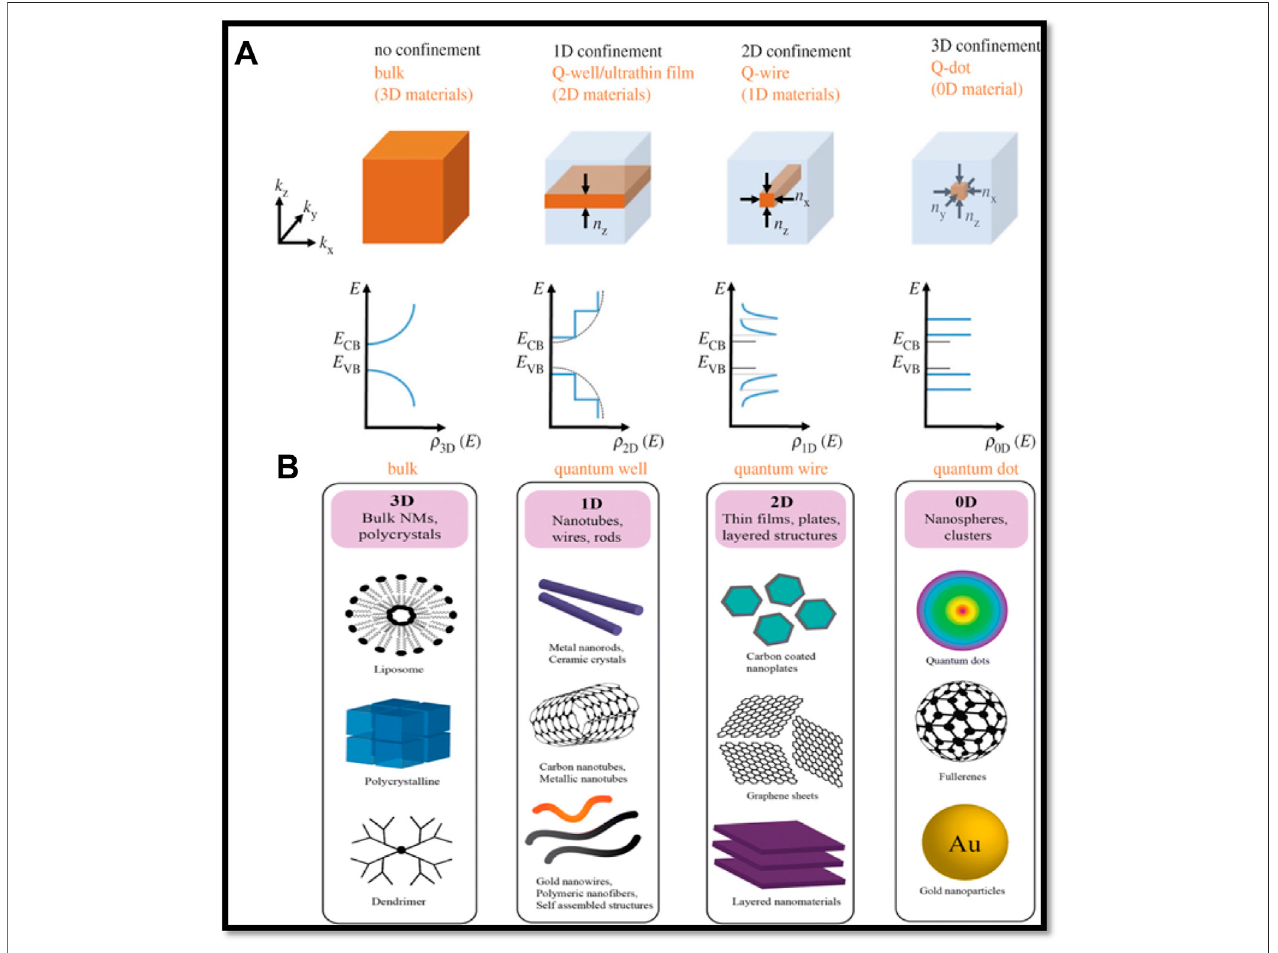
FIGURE 8 | (A) Density of state (Edvinsson, 2018) and (B) examples (Poh et al., 2018) of bulk, 2D-nanoplate, 1D-nanorod, and 0D-quantum dot.